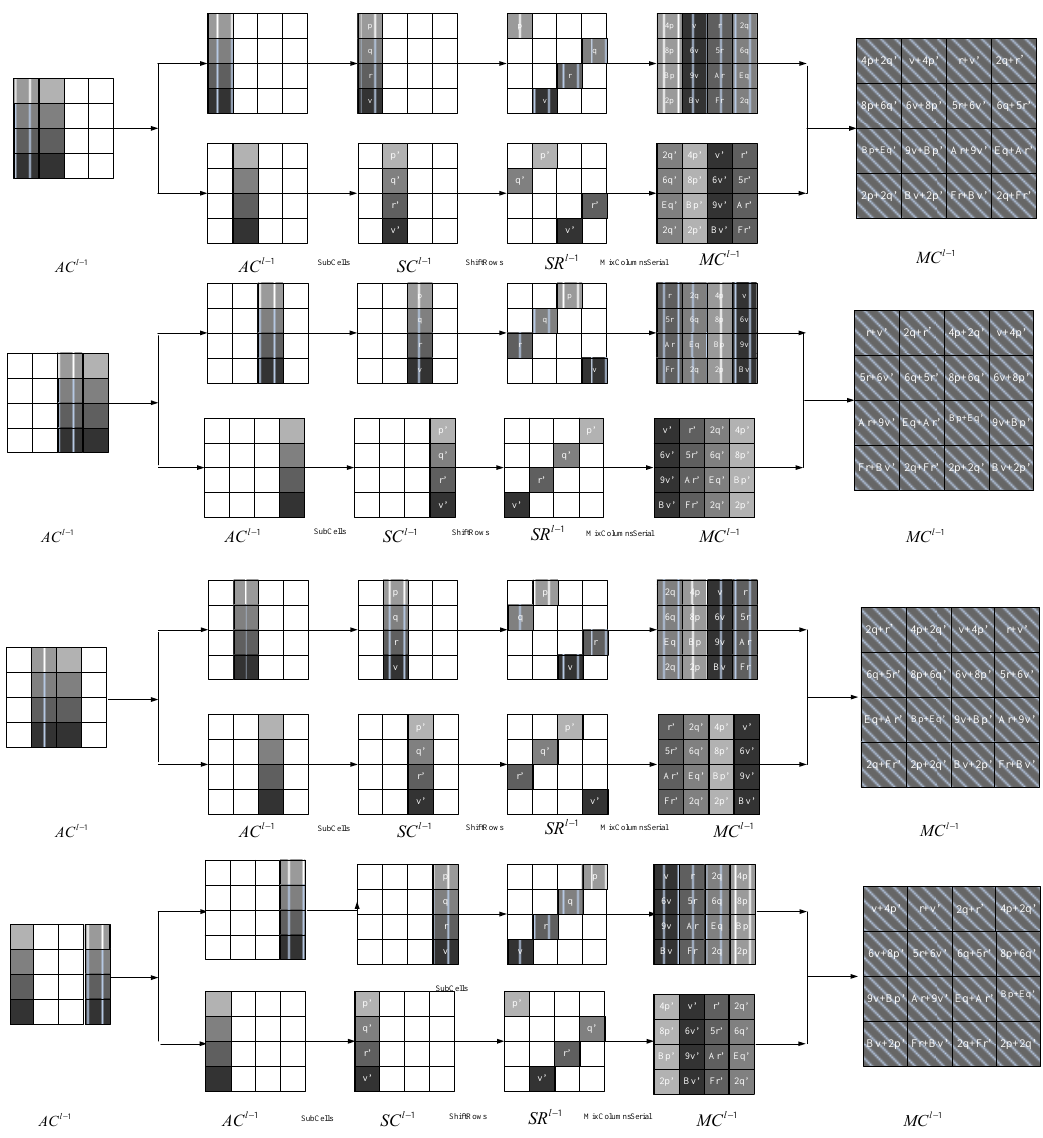
Fig. 3 The four relationships among the fault progagation values in the LED cipher